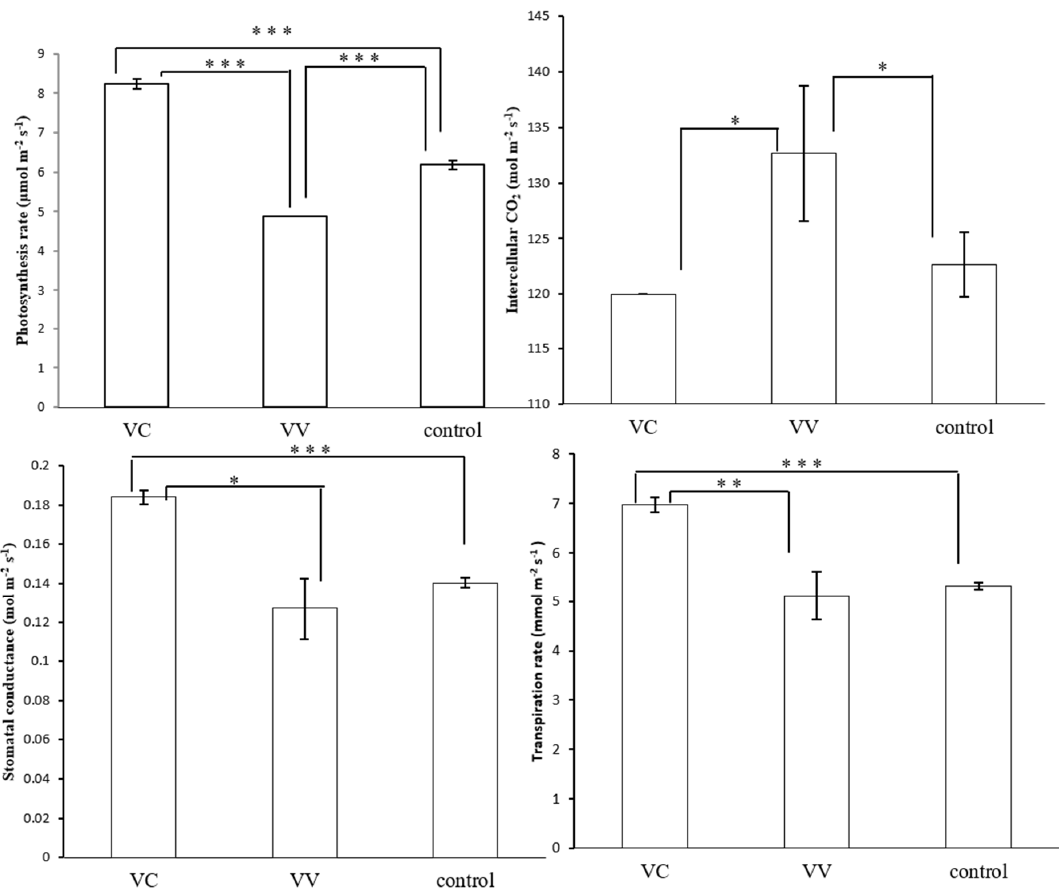
Figure 7. Analysis of photosynthesis characteristics in control, VIGS-vector, and VIGS-CtPPO at starting point. The photosynthesis rate, intercellular CO 2 , stomatal conductance, and transpiration rate were measured using an open gas-exchange system. Data are shown as mean ± SD of independent biological replicates. Asterisks indicate significant changes as measured by Student’s t t -test (* p < 0.05, ** p < 0.01, and *** p < 0.001).